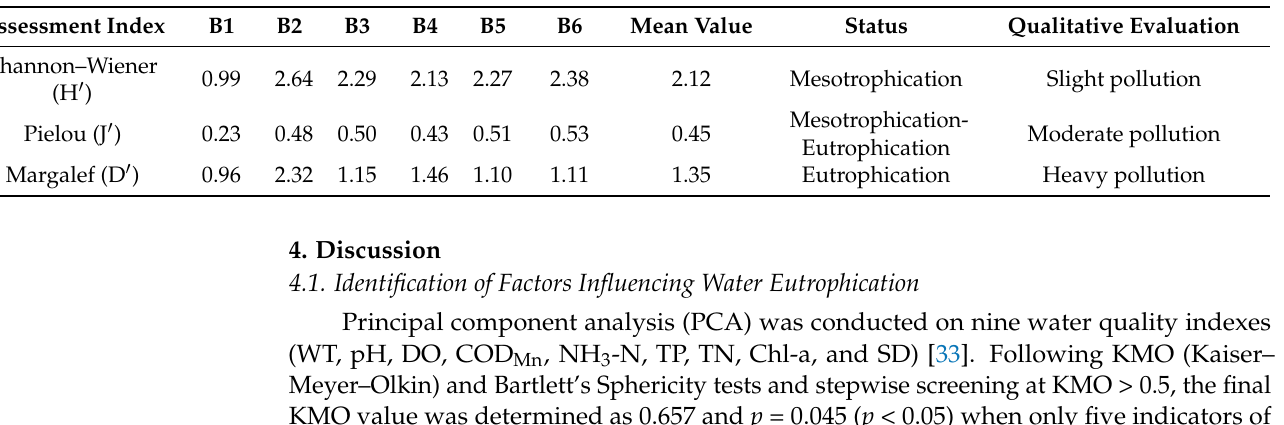
Table 4. Phytoplankton diversity index and